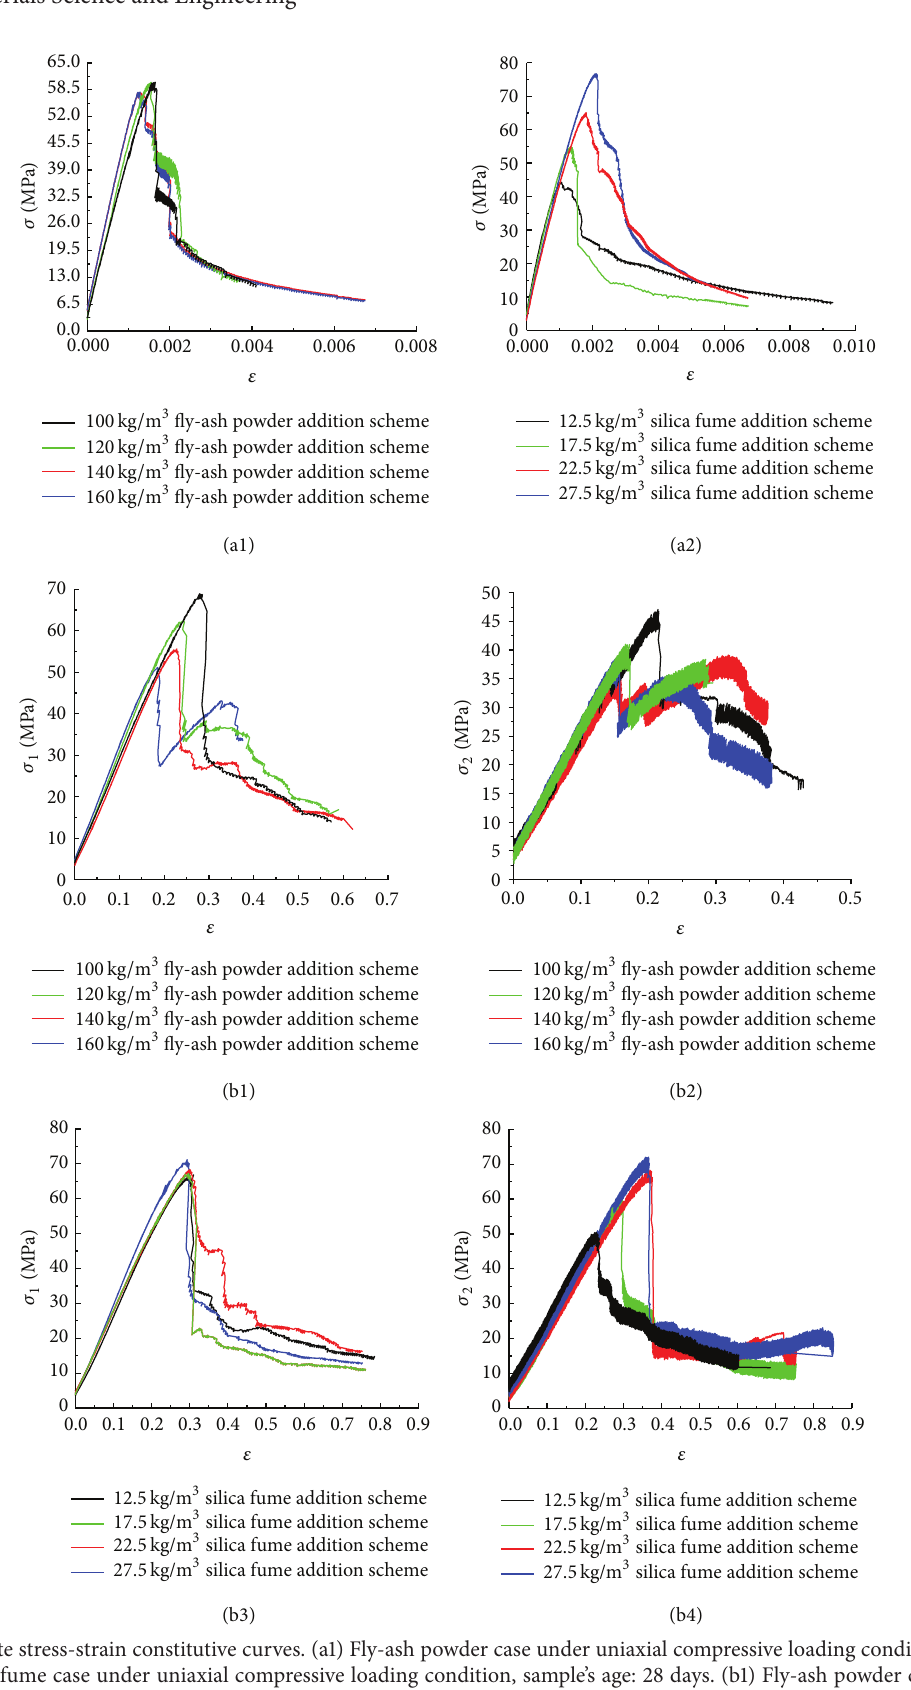
Figure 17: Complete stress-strain constitutive curves. (a1) Fly-ash powder case under uniaxial compressive loading condition, sample’s age: 28 days. (a2) Silica fume case under uniaxial compressive loading condition, sample’s age: 28 days. (b1) Fly-ash powder case under biaxial compressive loading condition, for vertical axis, sample’s age: 28 days. (b2) Fly-ash powder case under biaxial compressive loading condition, for horizontal axis, sample’s age: 28 days. (b3) Silica fume case under biaxial compressive loading condition, for vertical axis, sample’s age: 28 days. (b4) Silica fume case under biaxial compressive loading condition, for horizontal axis, sample’s age: 28